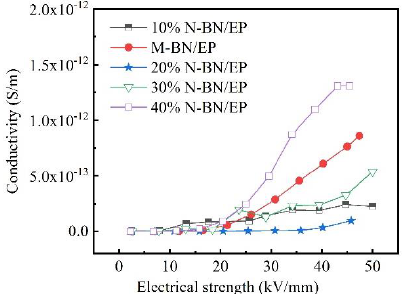
Figure 5. Conductivity of BN/EP composites depended on electrical strength at room temperature.